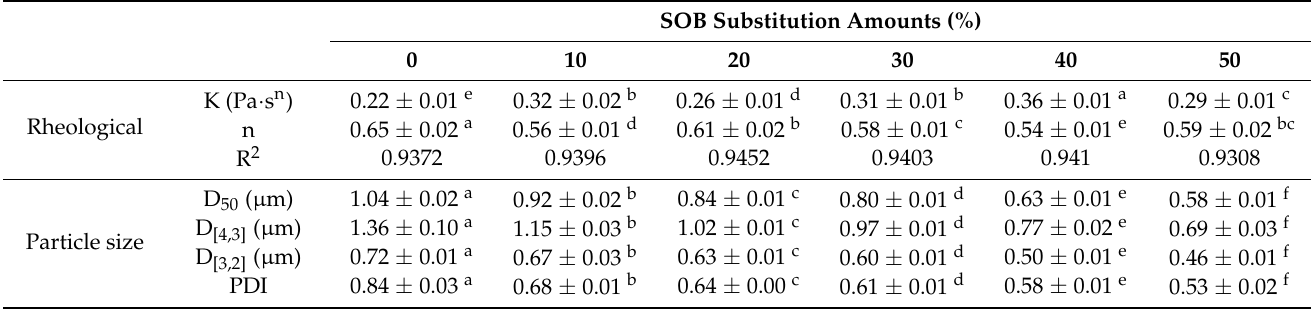
Figure 1. Effects of different SOB substitution amounts on ( A ) apparent viscosity and ( B ) particle size distribution of ice cream mixes. Table 1. Effects of different SOB substitution amounts on consistency index, flow behavior index, particle size and uniformity of ice cream mixes.